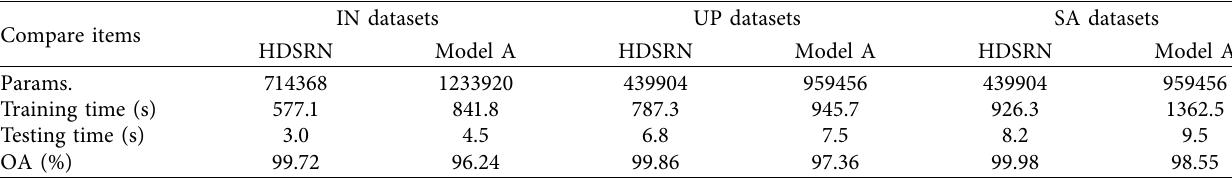
Table 6: Comparative experiment for depth-separable convolution.